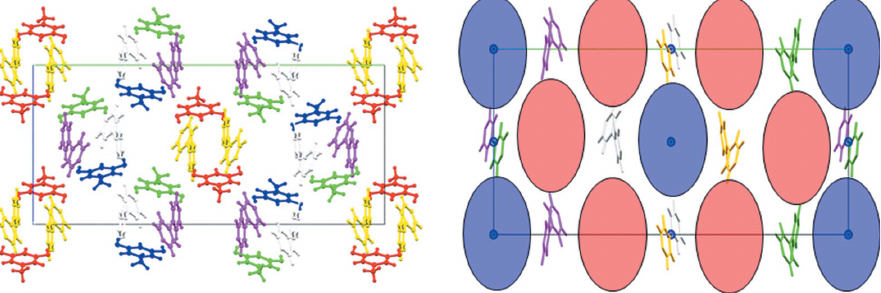
Figure 6 Arrangement of center and pseudo-center related synthons in form IV . Color coding is based on symmetry equivalence: blue: center of inversion; red: pseudo-center of inversion. Molecules of the same color are related by